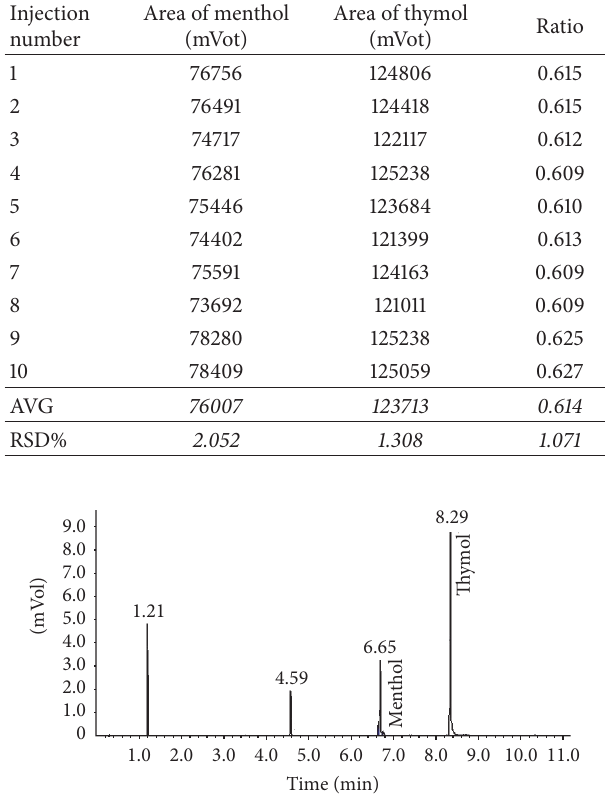
Table 2: System suitability and system precision result.